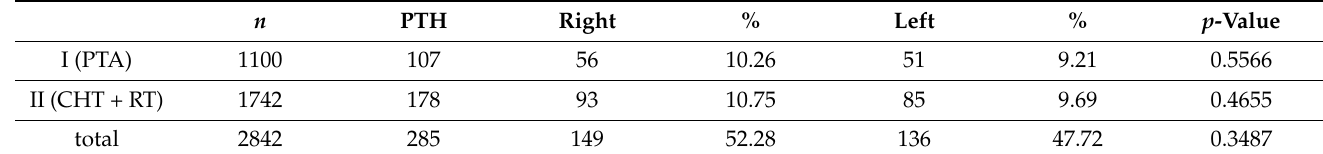
Table 4. Postoperative bleeding: right versus left sides.